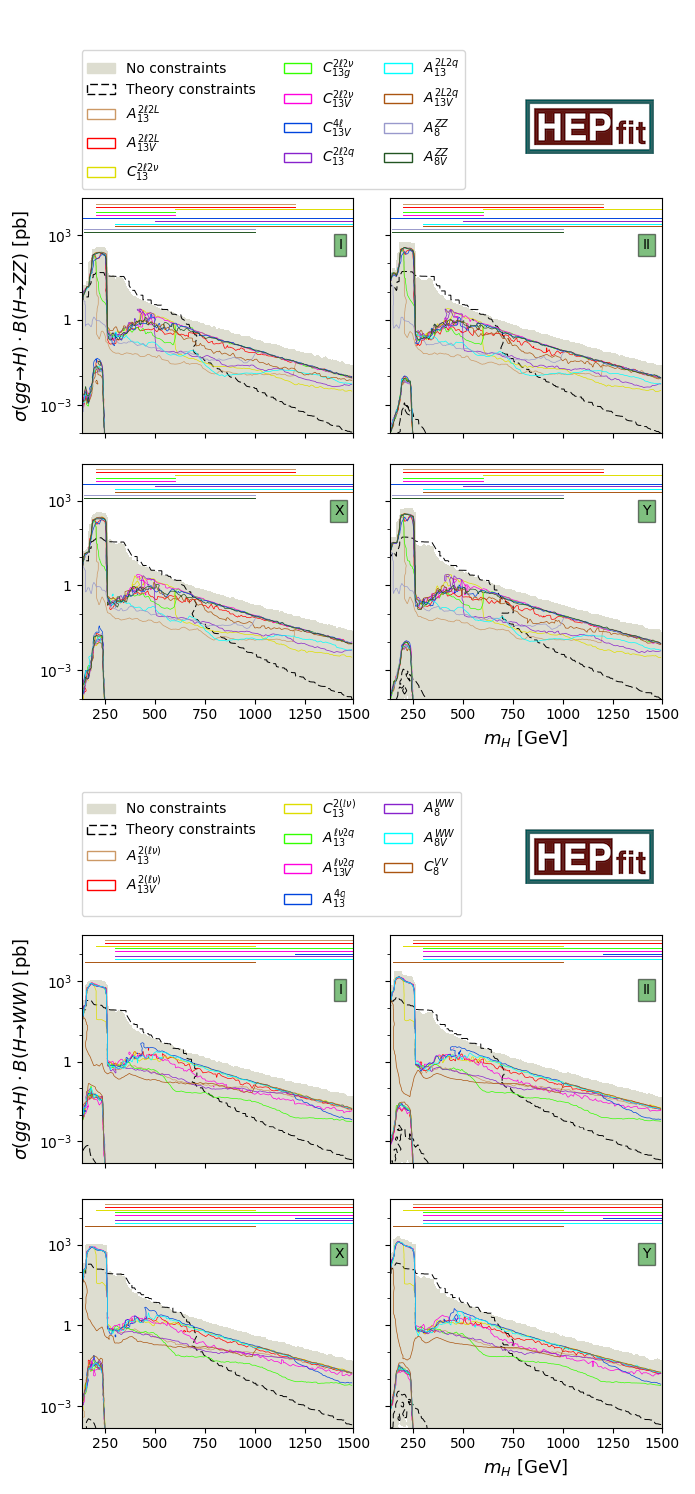
Figure 10 . 95% contours of the single searches for H ! ZZ (top) and the remaining H ! V V (bottom) in the (cid:27) (cid:1) B vs. m H planes for the four 2HDM types. For details, see text.